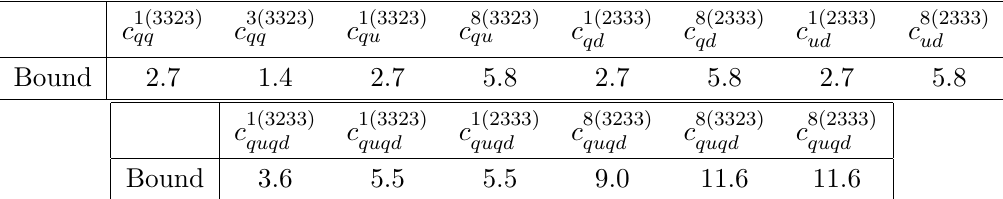
Table 5 . Expected bound on c for (cid:3) = 1 TeV in the HL-LHC assuming no systematics. They become a factor of 7 larger for a systematic uncertainty of 10 (cid:24)